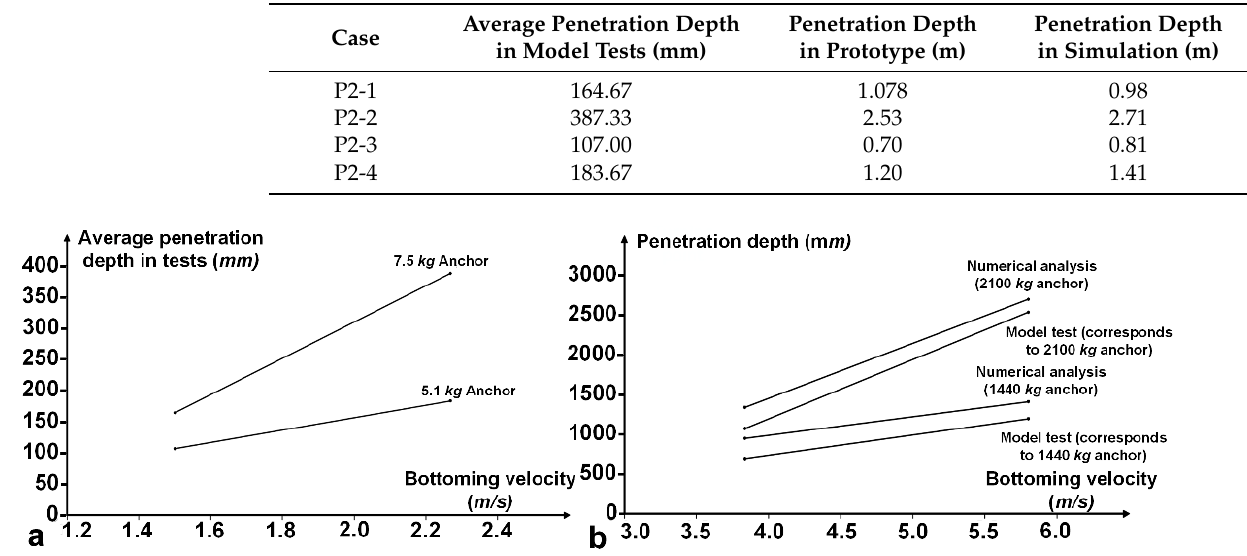
Table 15. Comparison of the penetration depth in the model test and numerical simulation.